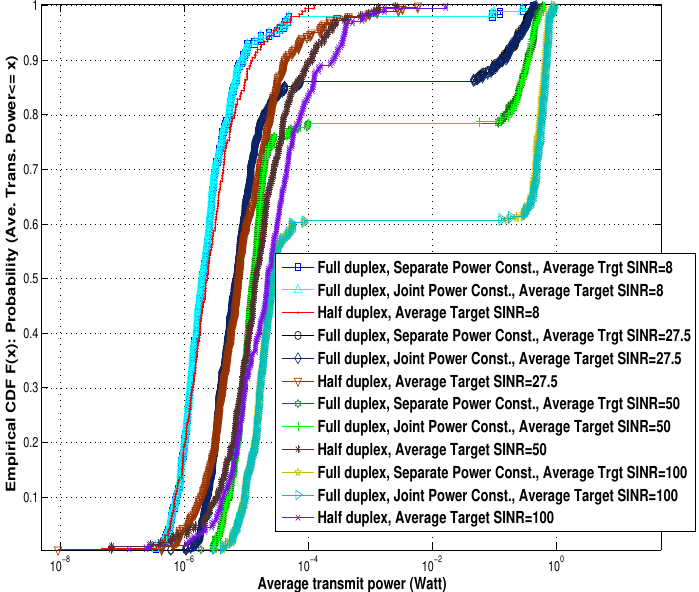
Figure 6. The CDF of the average transmit power in a 36-cell network using different transmission schemes under different average target